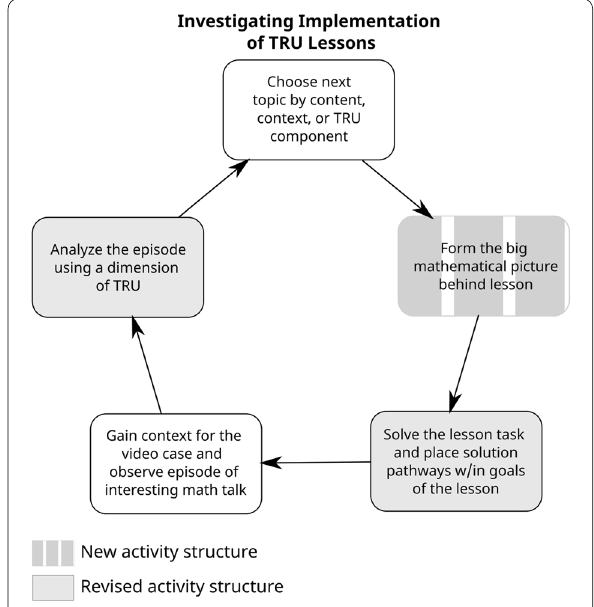
Fig. 8 Revised AIM–TRU learning